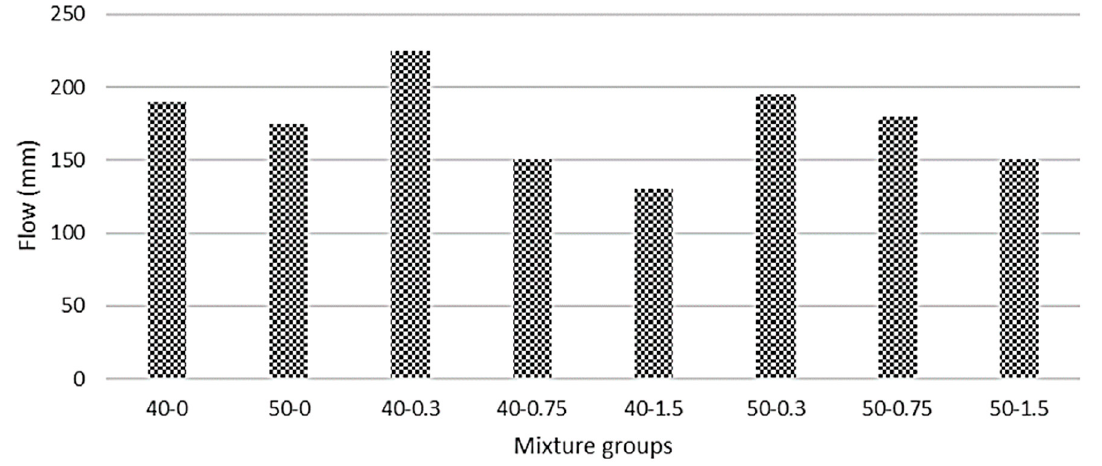
Figure 3. Flow values for basalt-reinforced bottom ash cement paste composites.